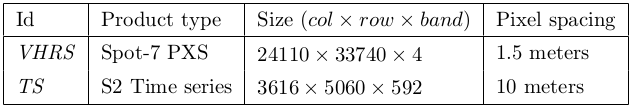
Table from the paper: A framework for remote sensing images processing using deep learning technique
Table text:
Id
Producttype
Size(col × row × band)
Pixelspacing
VHRS
Spot-7PXS
24110 × 33740 × 4
1.5meters
TS
S2Timeseries
3616 × 5060 × 592
10meters